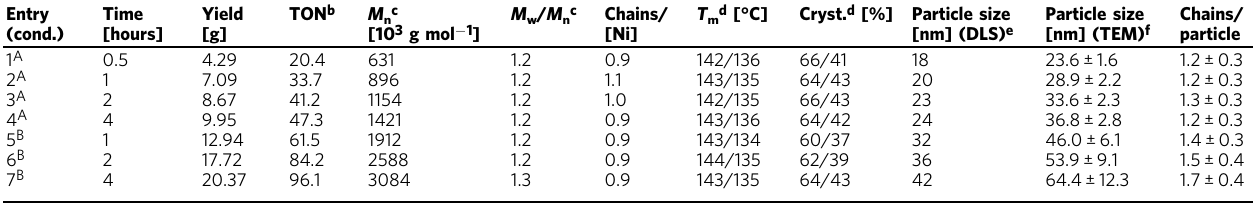
Table 2 Ethylene polymerization results of precatalyst 1-C 6 F 13 /PEG in aqueous surfactant solution a